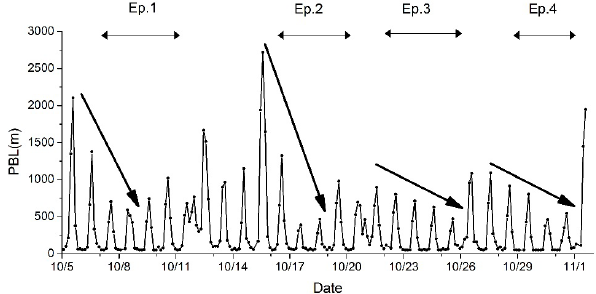
Figure 12. Time series of the PBL (planetary boundary layer) from 5 October to 2 November